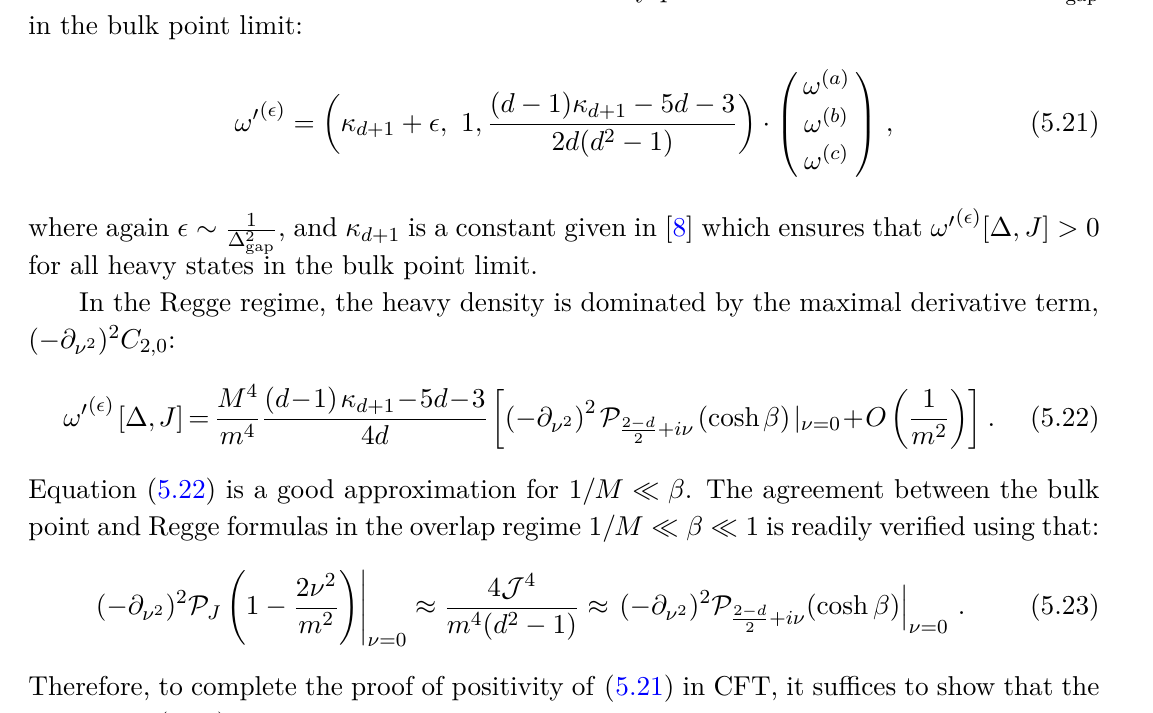
Figure 13. Derivatives around zero momentum transfer ( − ∂ for all impact parameters, even beyond the AdS radius ( β ∼ 1 ). At small impact parameters, they reproduce the flat space behavior ∼ β 2 n